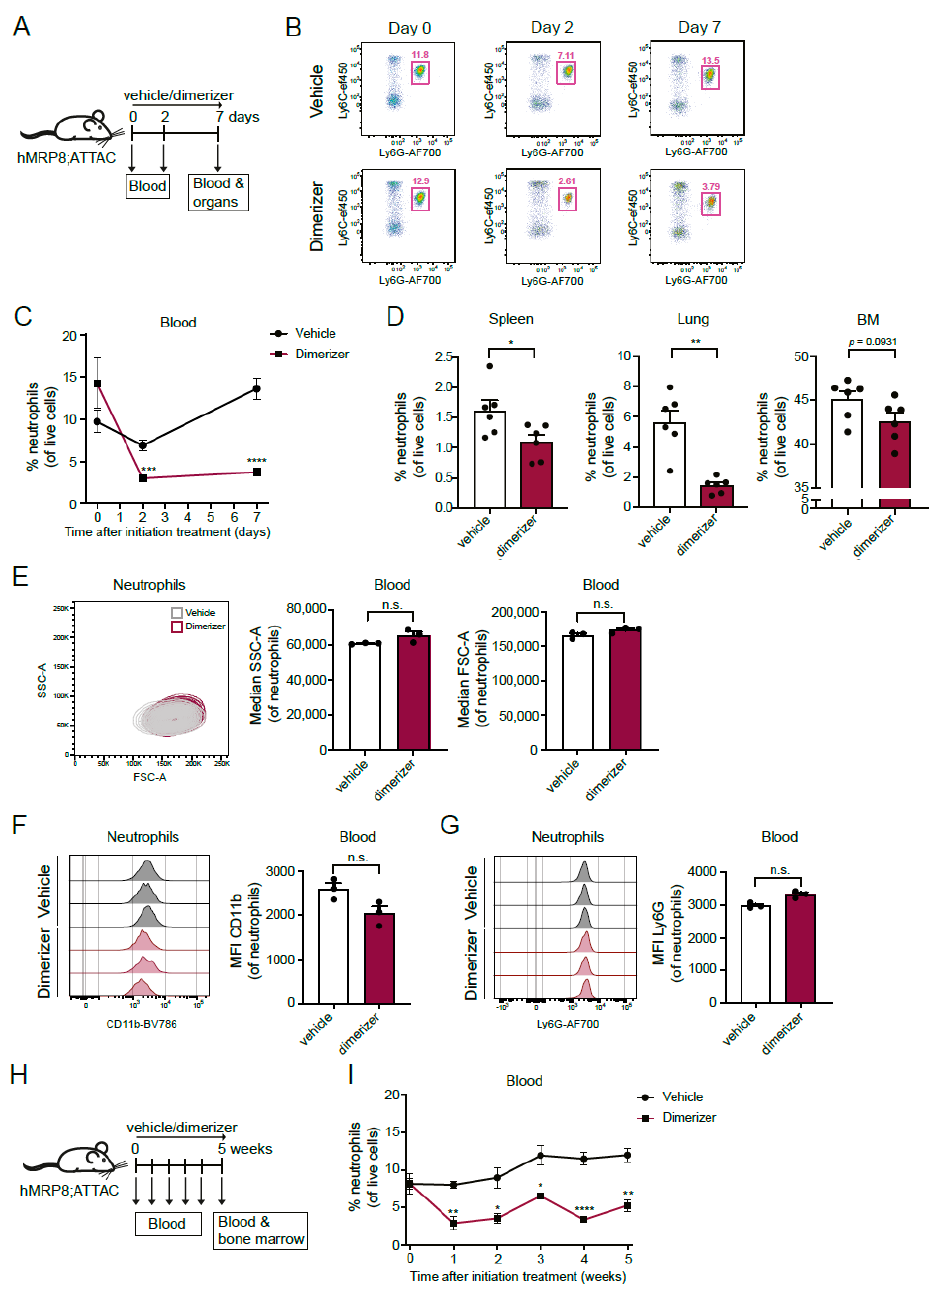
Figure 3. Dimerizer treatment reduces neutrophil frequency in hMRP8-ATTAC mice. ( A ) Schematic representation of the experimental design. Female homozygous hMRP8-ATTAC mice were treated daily with vehicle or dimerizer for seven consecutive days. Blood was analyzed by flow cytometry